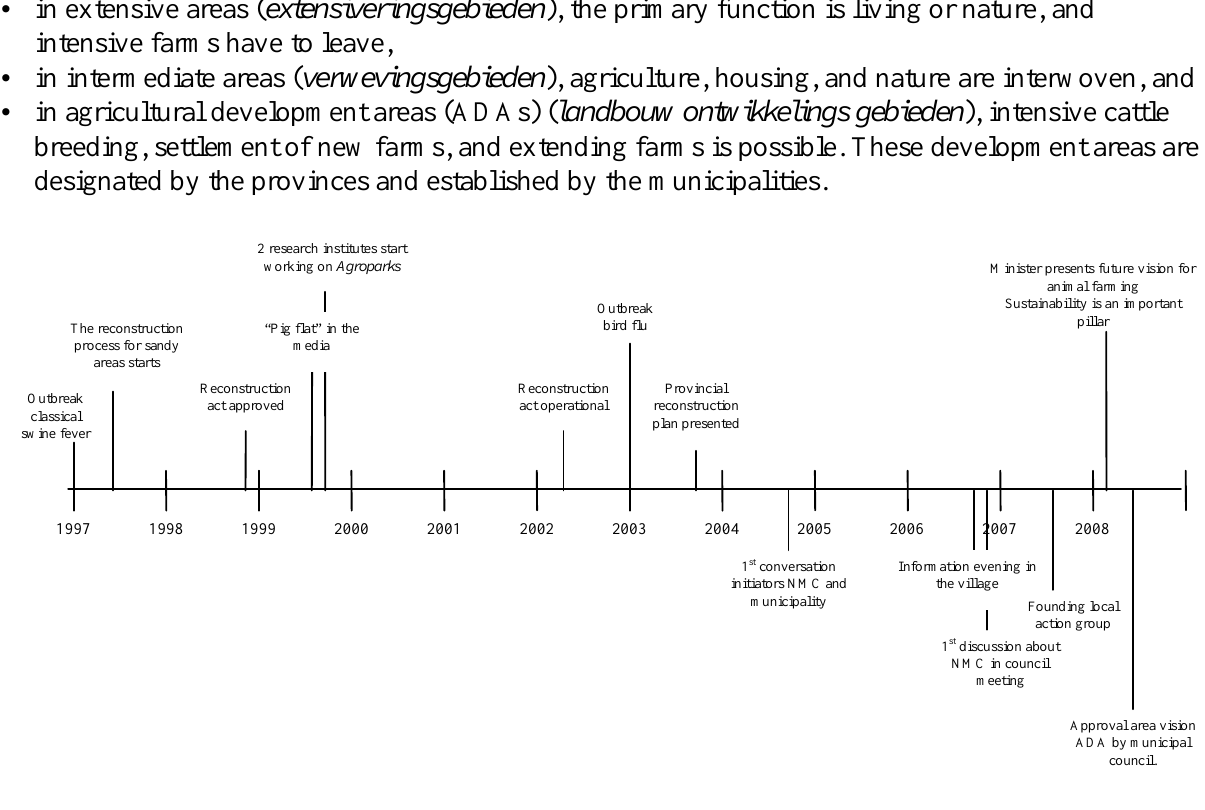
Figure A1.1: Reconstruction of the decision-making process (national and provincial events on top of timeline, municipal events